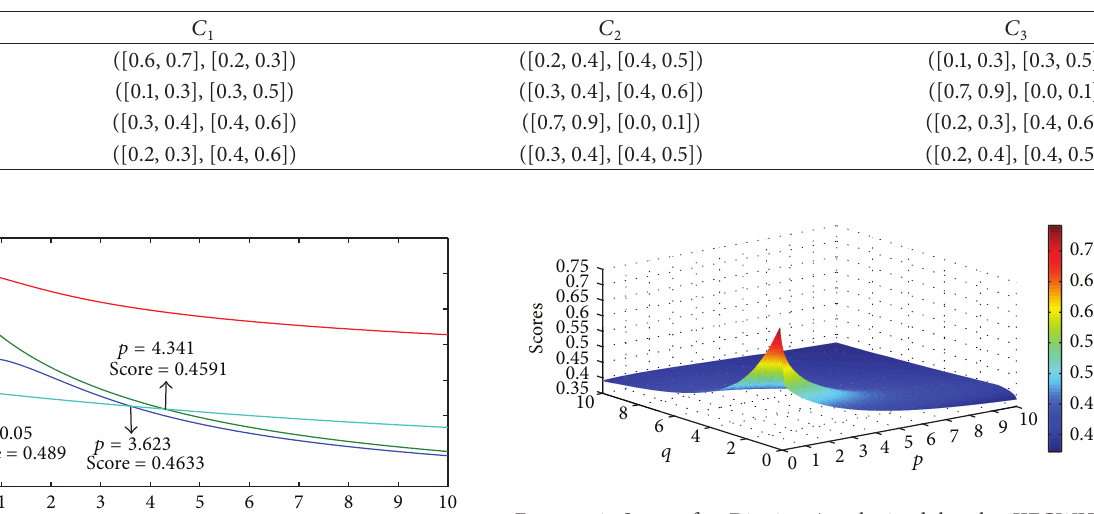
Table 2: The interval-valued intuitionistic fuzzy decision matrix 𝐵 .